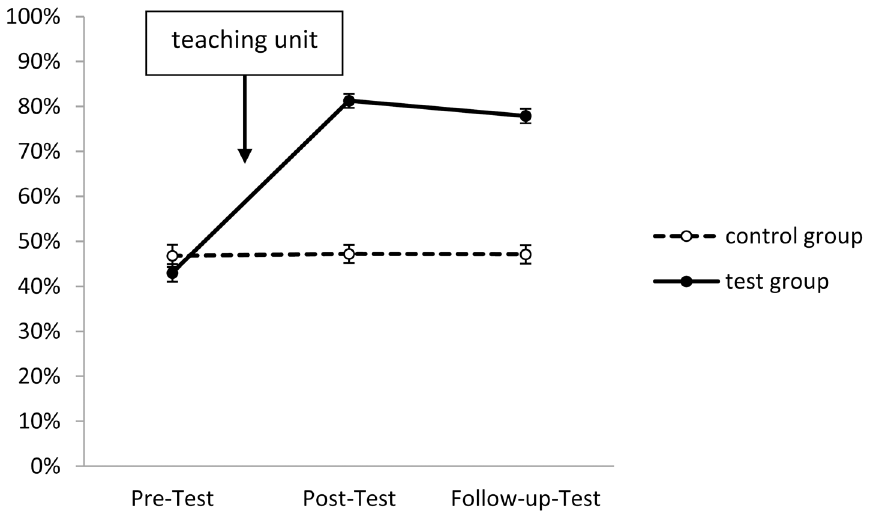
doi:10.1371/journal.pone.0150014.g001